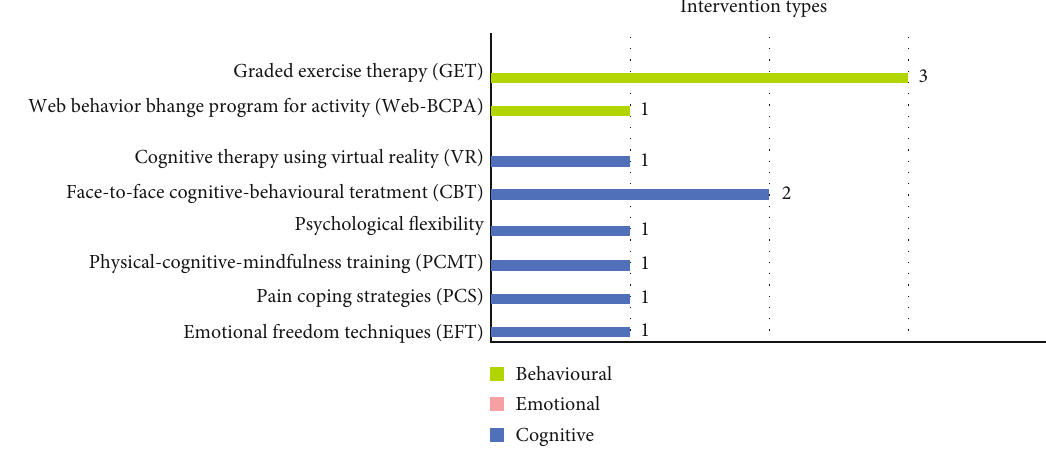
Figure 3: Frequency of the intervention types based on the psychological aspects of pain.